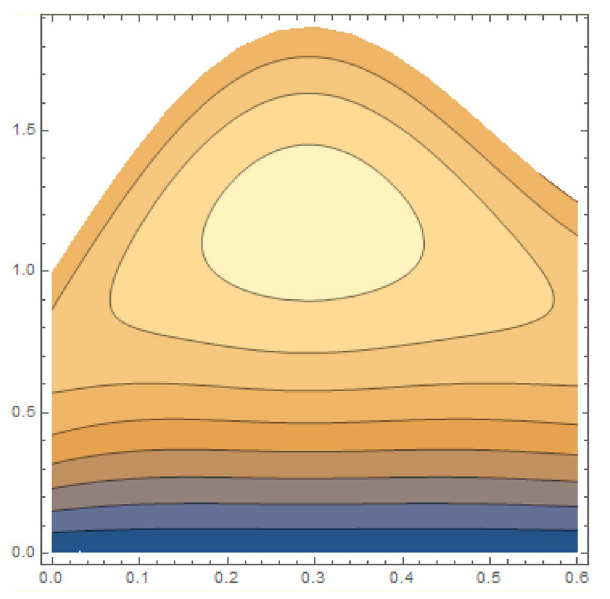
Figure 27. Streamlines of m1 =